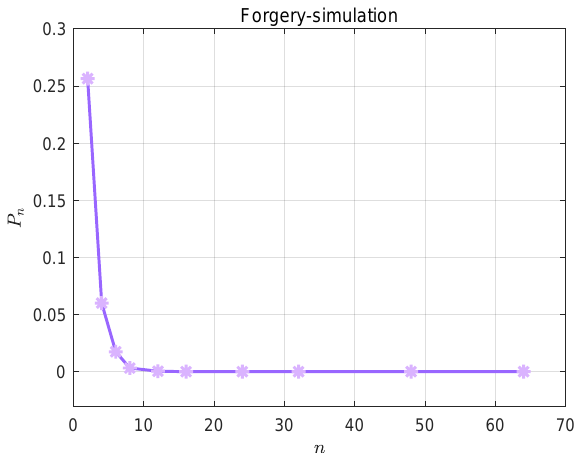
Figure 6. Successful probability P n for forging the random binary sequence S as a function of the length n of the sequence S